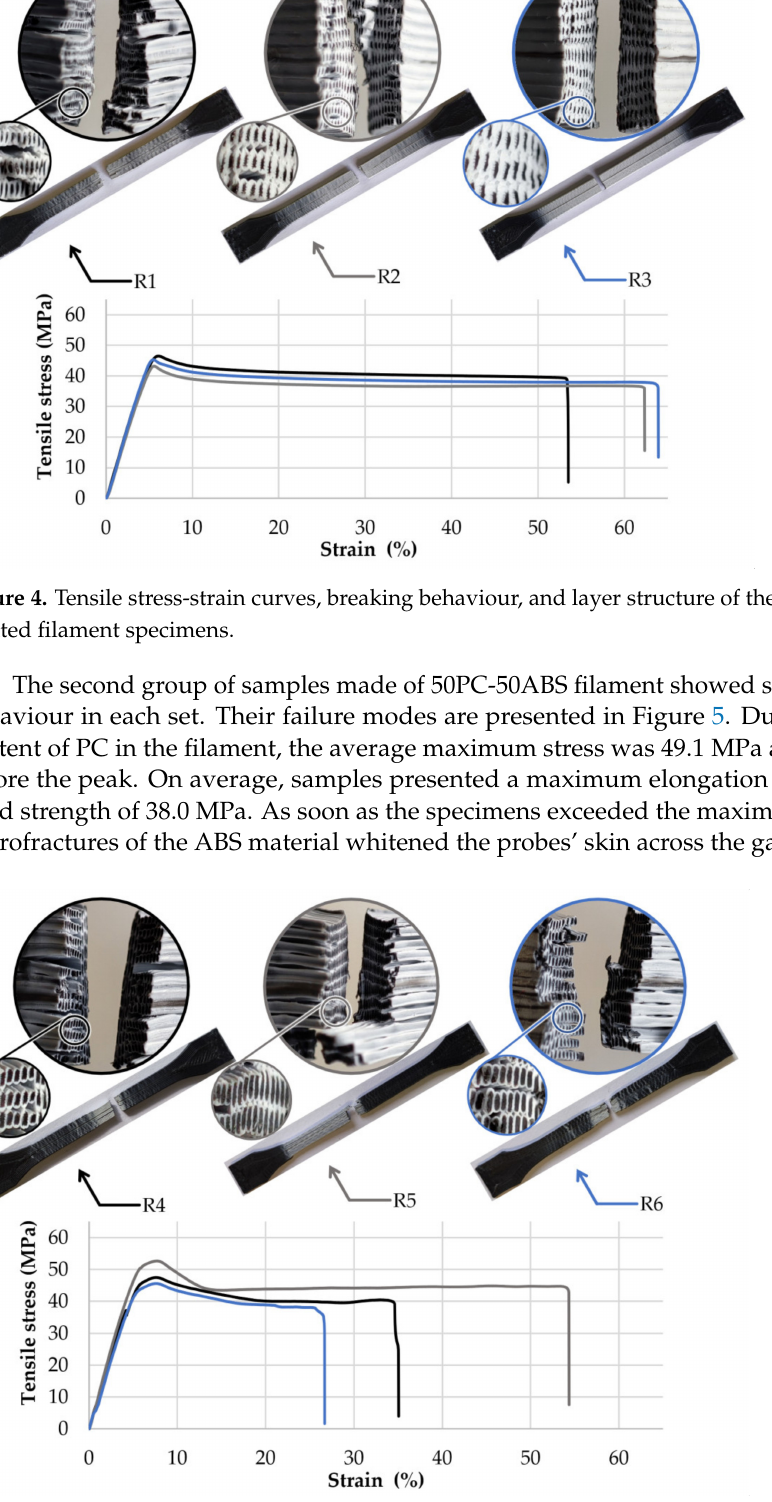
Figure 5. Tensile stress-strain curves, breaking behaviour, and layer structure of the 50PC-50ABS 3D printed filament